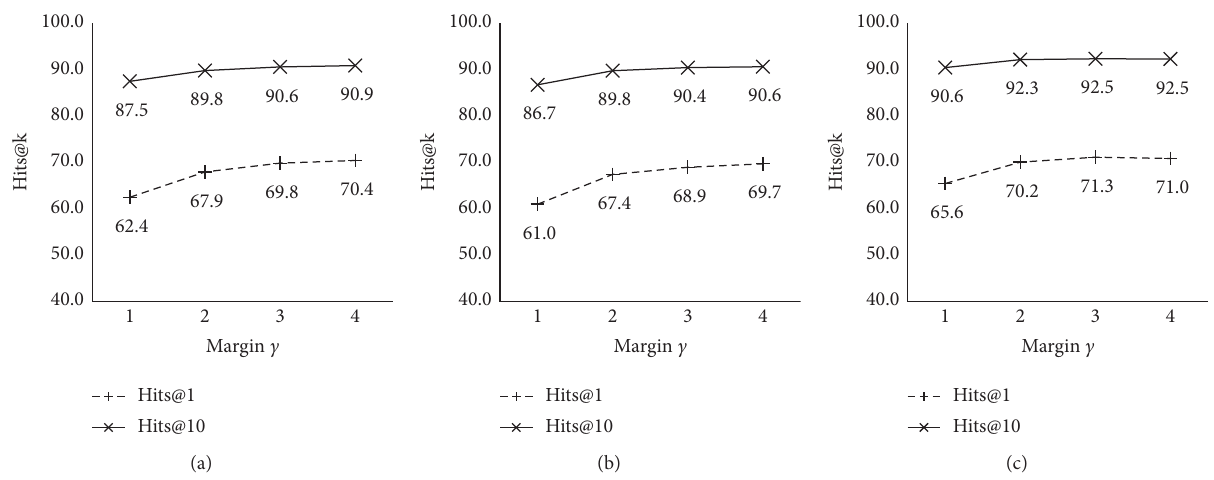
ZH-EN . (b) DBP JA-EN . (c) DBP FR-EN .